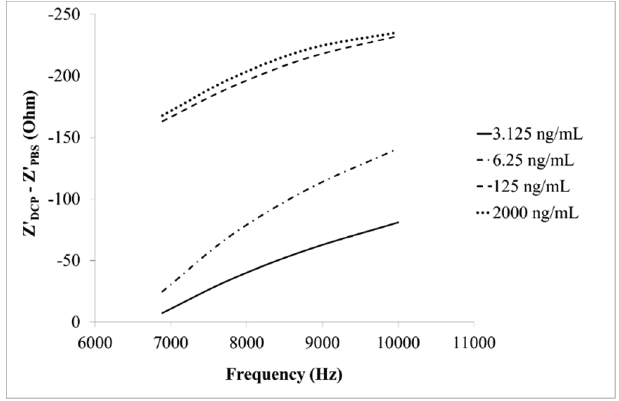
Figure 4. The real part of impedance (Z') response of the immunosensor to DCP of various concentrations (3.125, 6.25, 125, 2000 ng/mL) within a specific frequency range (6.887–10